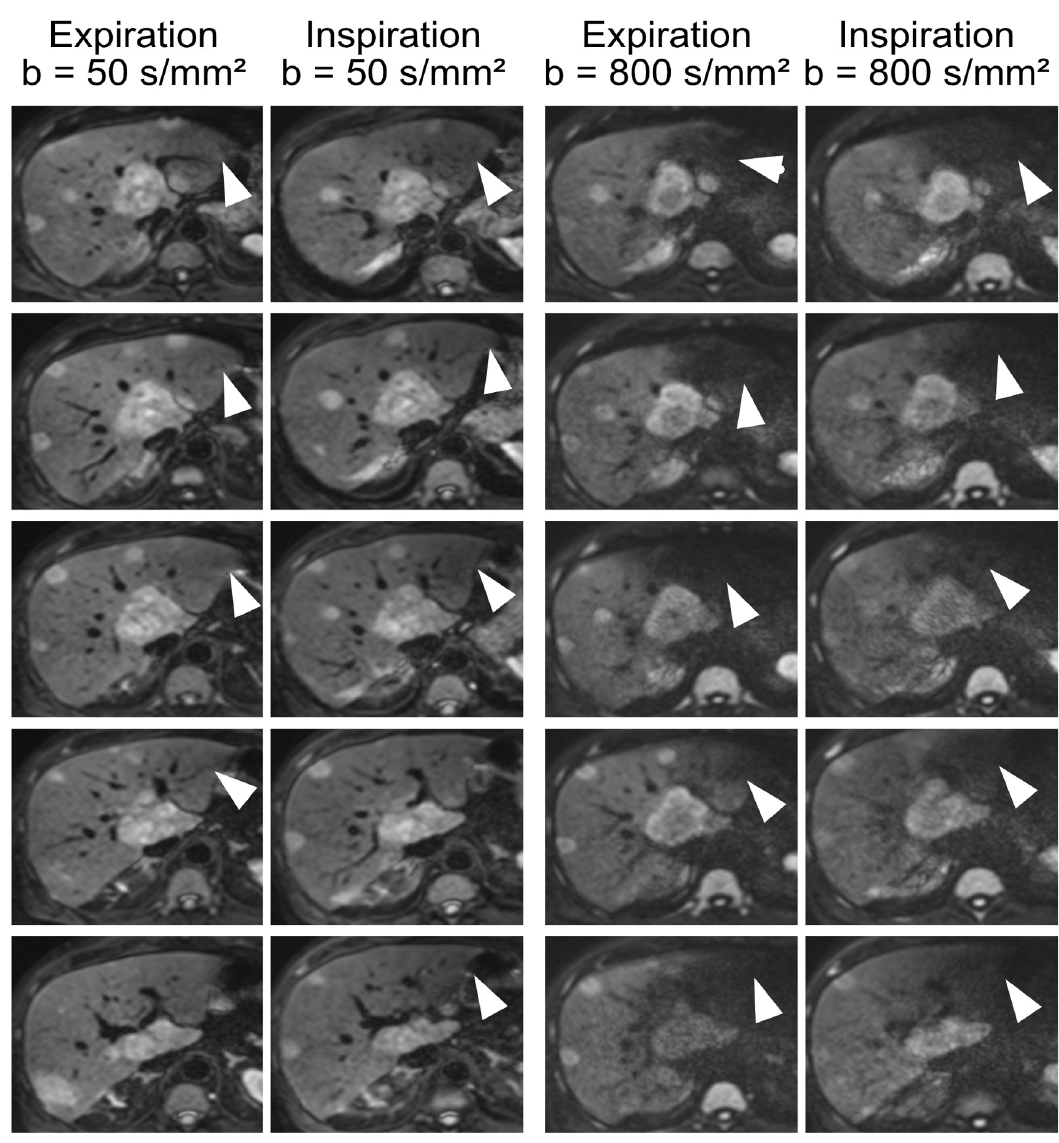
Fig 2. Diffusion weighted images of one patient acquired with breath-hold in expiration and inspiration at two b-values. Each row shows the same slice. The pulsation artifact is marked by arrows.